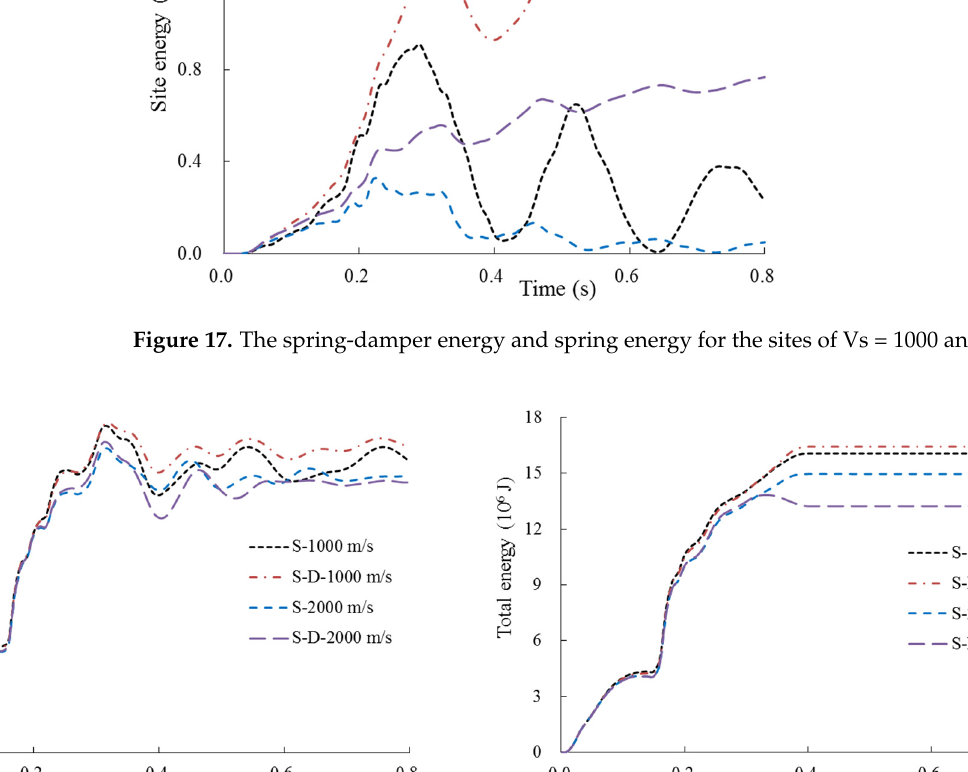
Figure 18. The internal energy and total energy of containment for the sites of Vs = 1000 and 2000 m/s. ( a ) Internal energy. ( b ) Total energy.